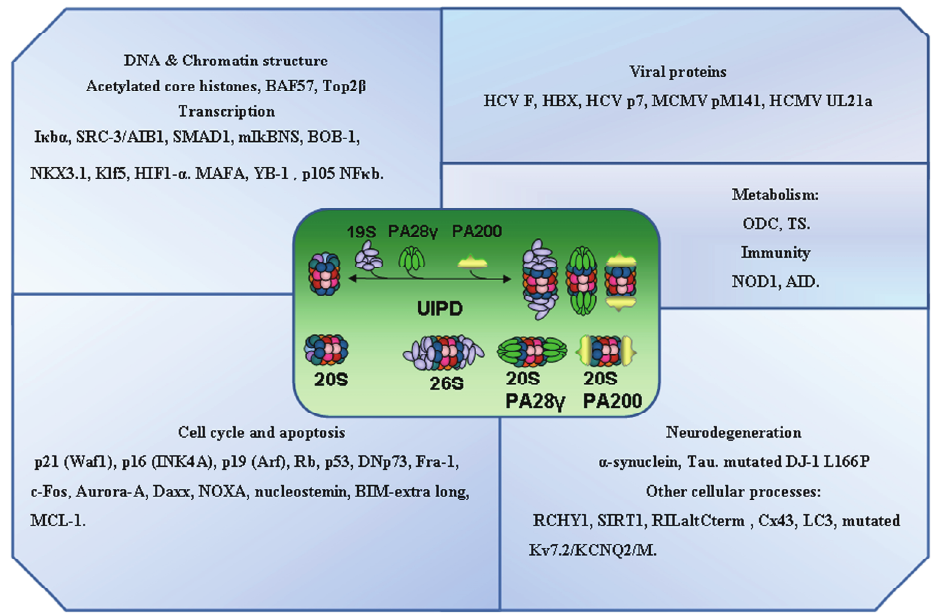
Figure 2. Classification of mammalian proteins reported to be degraded by an ubiquitin-independent proteasomal pathway. The protein function or cellular processes in which those proteins are involved have been used to group the different mammalian proteins that have been shown to be subjected to Ubiquitin-Independent Proteasomal Degradations (UIPD) by the 20S or 26S proteasome, or facilitated by activators (PA28(cid:5) and PA200) of the proteasome. A full description and details of the individual proteins and their UIPD mechanism may be found in the main